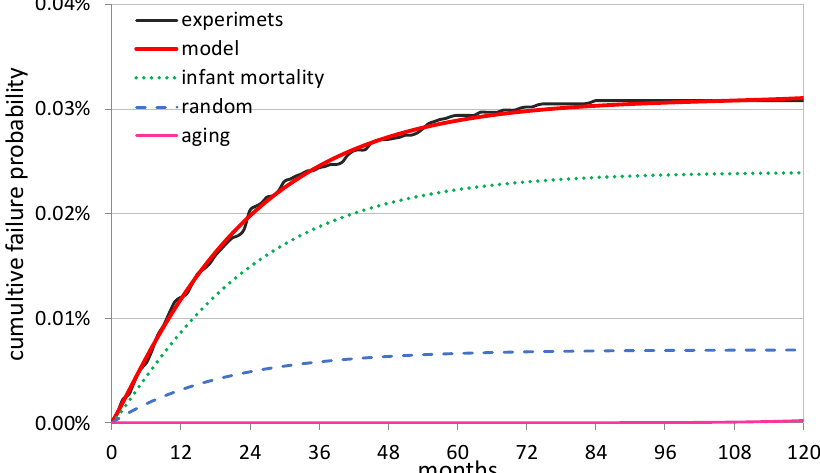
Figure 8. Cumulative failure probability of integrated circuits: experimental data, model and single components of the model.